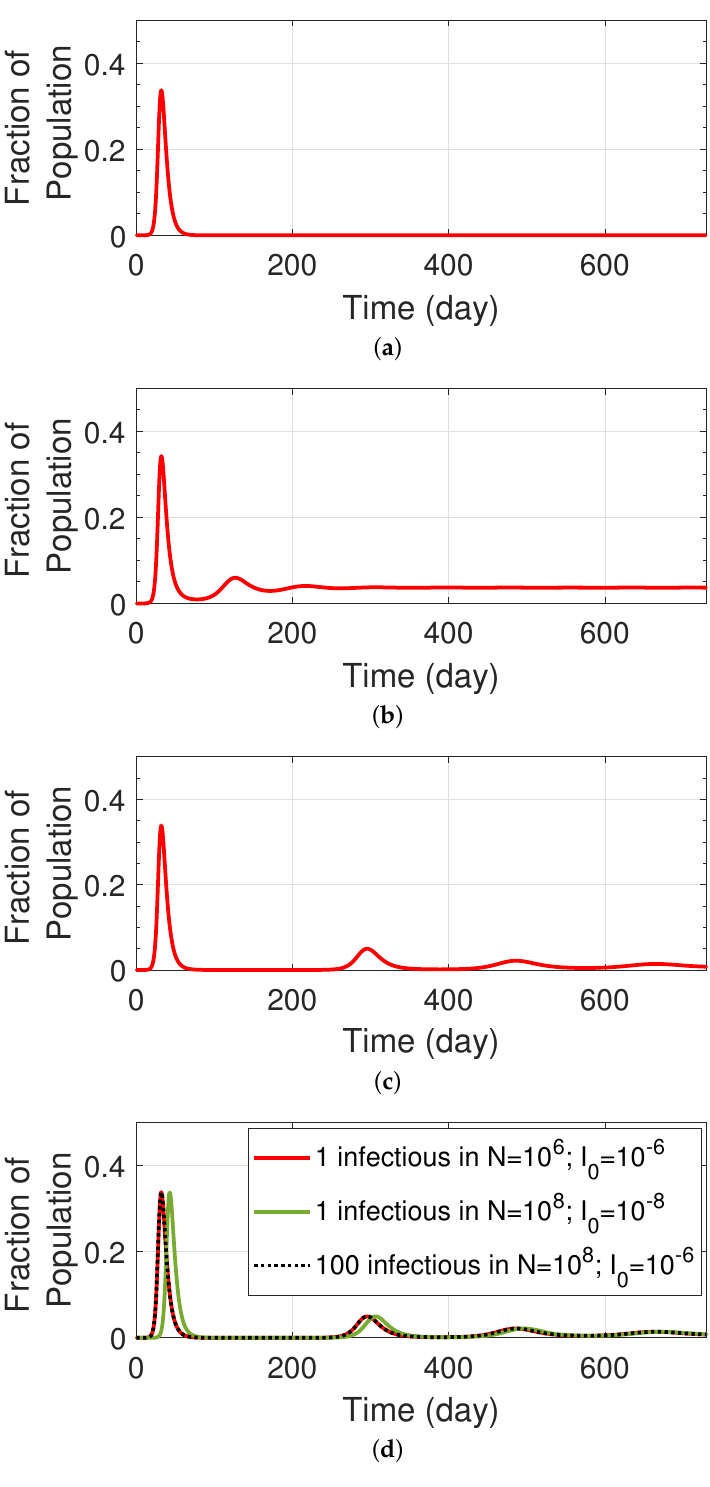
Figure 2. The fraction of infectious population for wild type virus projected by ( a ) classic SIR model; ( b ) classic SIRS model with 3 months natural immunity; ( c ) classic SIRS model with 12 months natural immunity; ( d ) classic SIRS model with different population sizes and different numbers of initial infectious individuals. Models are depicted in Figure